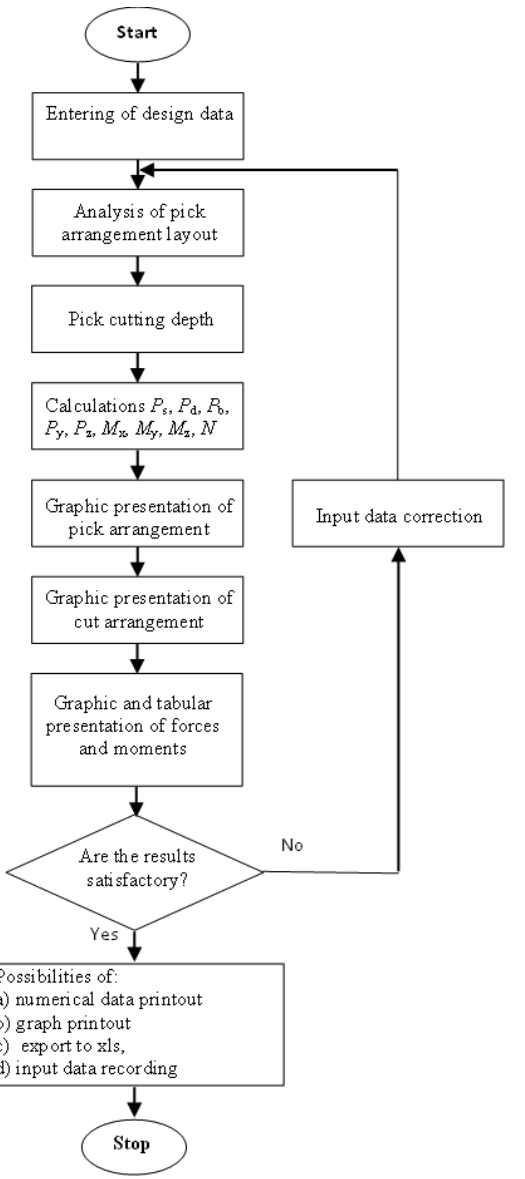
Figure 4. Block diagram of the program for designing the shearer cutting head [29].